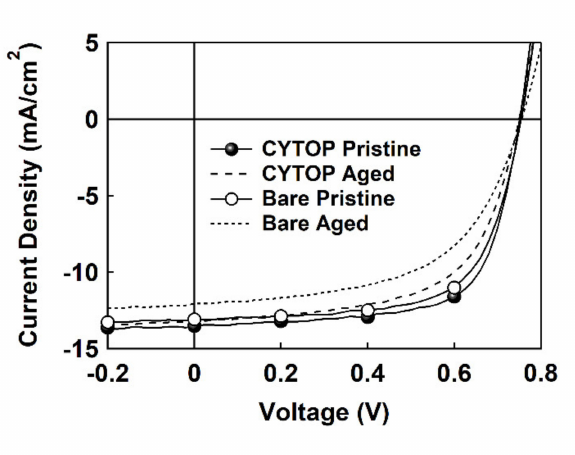
Figure 2. Current density-voltage (J-V) characteristics of CYTOP-encapsulated and bare OSCs before and after